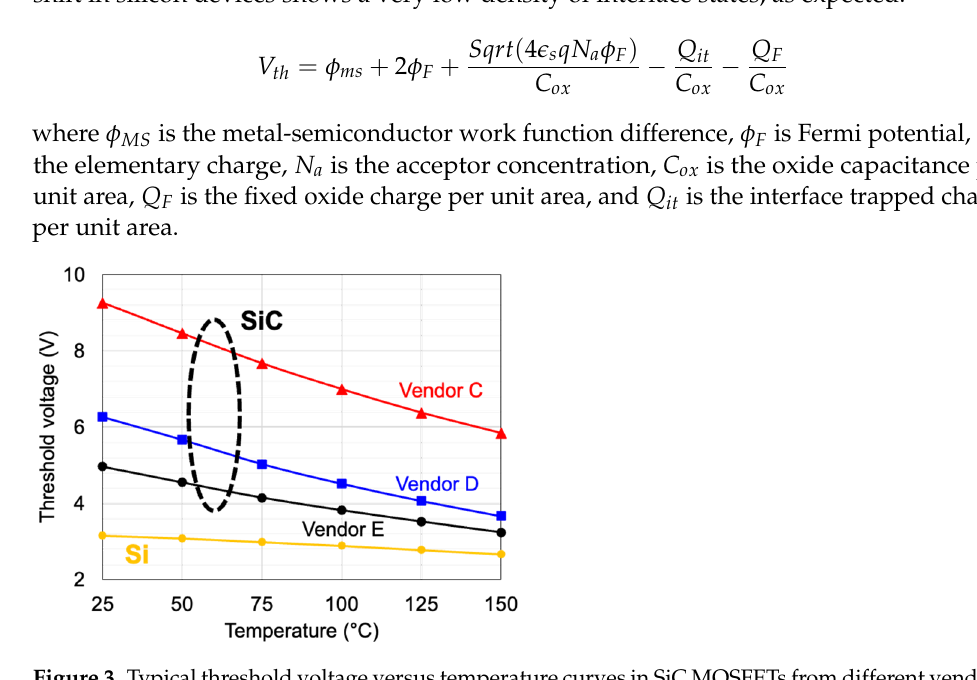
Figure 5. Energy band diagrams of MOS structure under ( a ) equilibrium; ( b ) positive; ( c ) negative bias conditions showing tunneling of electrons and holes in either direction. The curves in Figure 6 demonstrate threshold voltage shifts under various bias-stress conditions. In the case of devices from vendors C, D, and E, threshold voltage shifts of 0.50, 0.35, and 0.10 V, respectively, are measured with a positive DC bias of +20 V for 50 h. Devices from vendor C showed the greatest shift in threshold voltage, possibly due to the high density of border traps within the gate oxide. Almost all vendors exhibit the same trend in threshold voltage shift with different bias stresses. In contrast, when the gate is biased at − 10 V for 50 h, the threshold voltage shifts in the negative direction. For device C, the maximum shift is about − 0.2 V while devices A and B show shift less than − 0.1 V. Considering the differences in device performance among various manufacturers, some vendors, such as vendor E, have significantly reduced the border traps in the gate oxide by means of the better gate oxidation process. The positive bias stress measurements at high temperatures for vendors C and D are also shown in Figure 7. At high temperatures, the threshold voltage shift under positive bias is much more pronounced. Since the temperature dependence of the F–N tunneling mechanism is small, trap-to-trap tunneling is postulated to be the dominant mechanism.